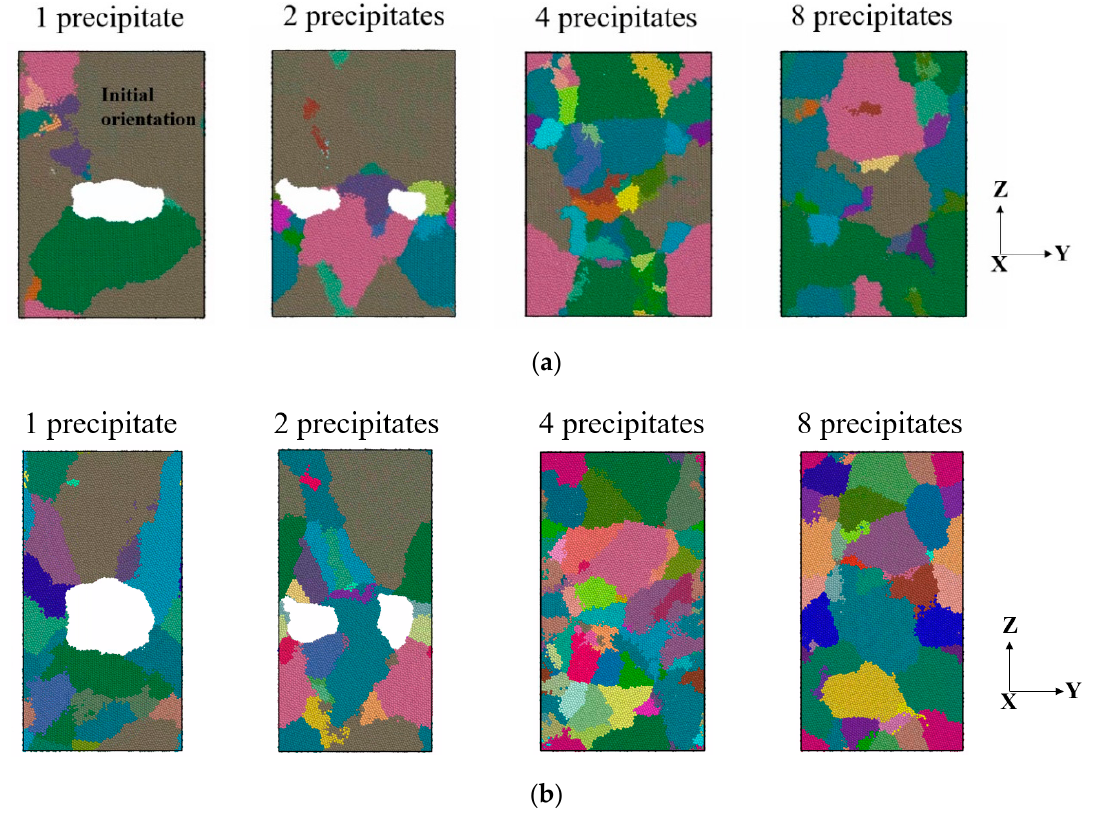
Figure 11. Atomic slices of the system with 1, 2, 4, and 8 precipitates ( a ) at strain 0.268 ( b ) at strain 0.460.